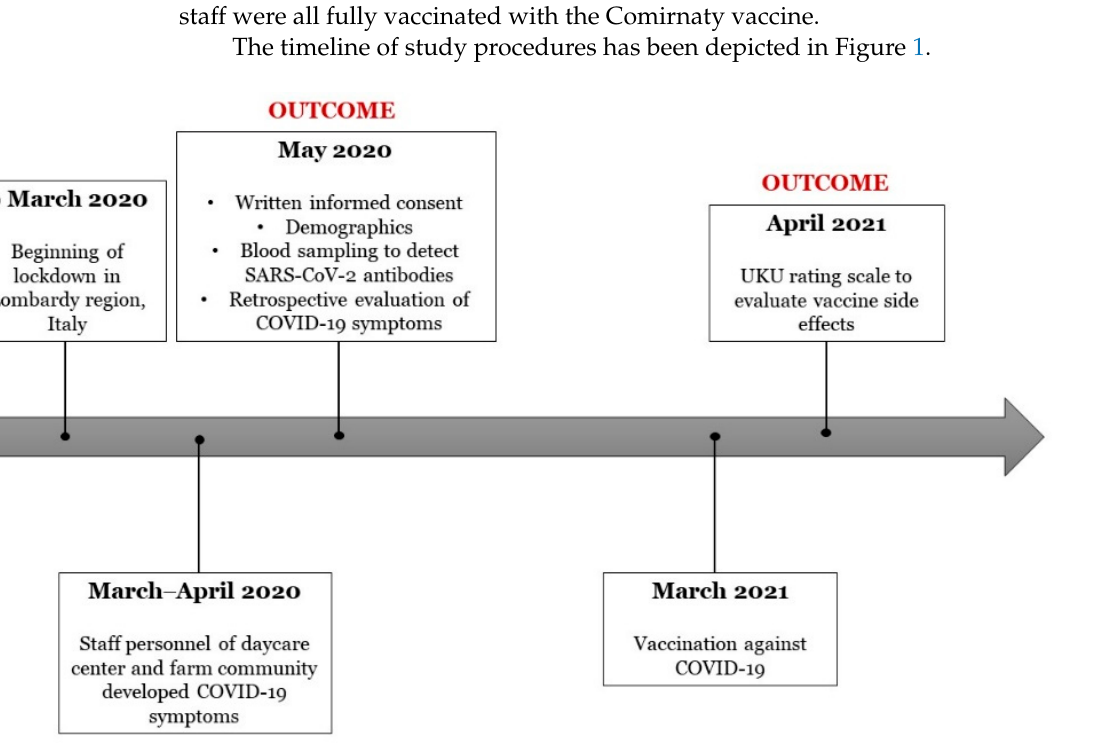
Figure 1. Timeline of the study procedures.